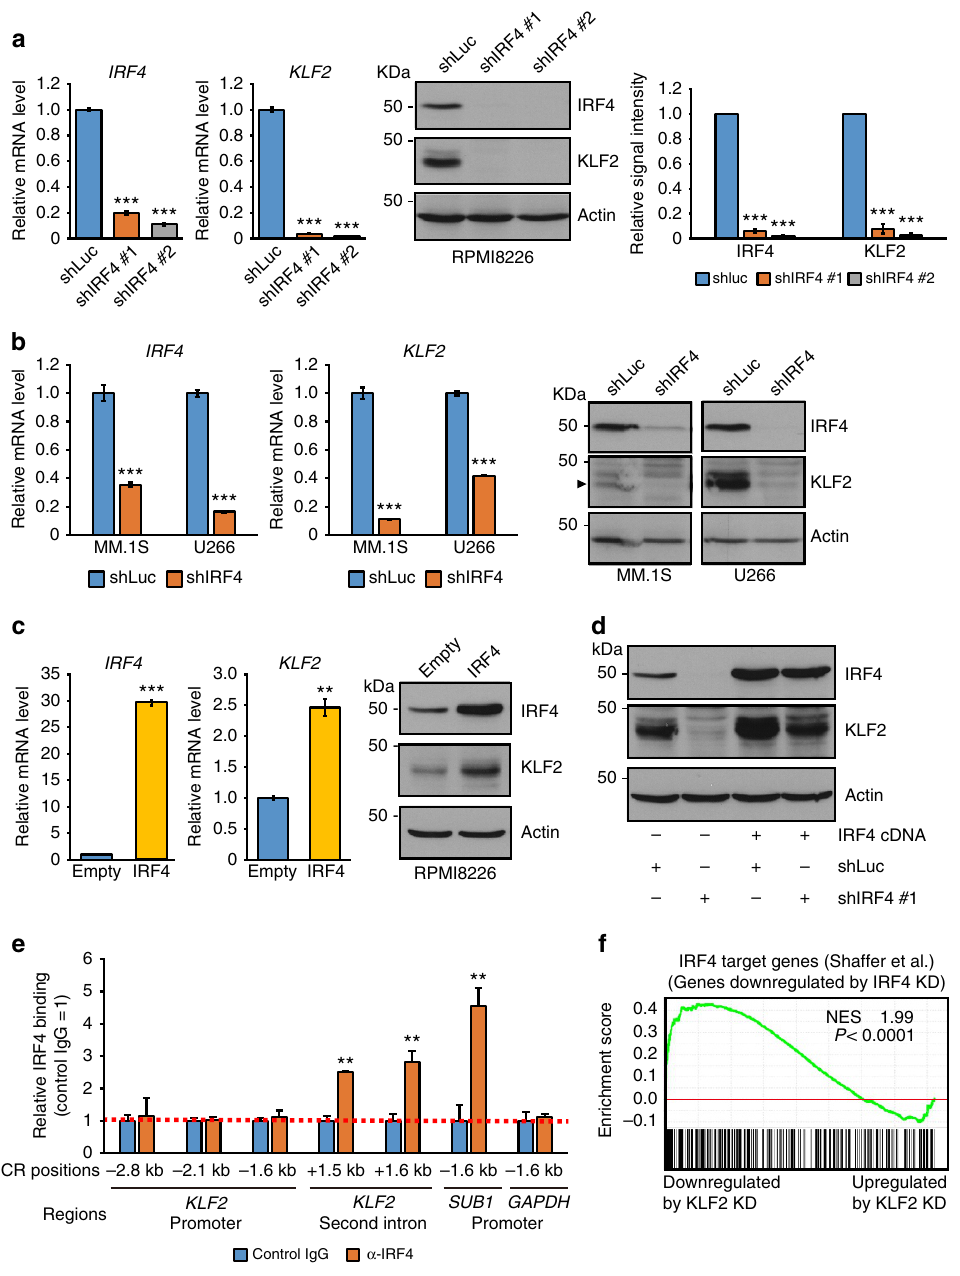
Figure 6 | KLF2 is a direct target of IRF4 transactivation in MM cells. ( a , b ) Quantitative real-time PCR and immunoblot analysis of IRF4 and KLF2 in RPMI8226 ( a ), MM.1S and U266 ( b ) cells transduced with either shRNA targeting IRF4 (shIRF4) or shLuc. ( a , right panel) Shown are the relative signal intensity (shLuc ¼ 1) normalized by Actin. Error bars represent s.e.m. of three independent experiments. ( c ) Quantitative real-time PCR and immunoblot analysis of IRF4 and KLF2 after overexpression of IRF4 in RPMI8226 cells. ( d ) RPMI8226 cells expressing the IRF4 cDNA or empty vector were transduced with shIRF4 #1 that targets the 3 0 untranslated region of IRF4 or shLuc by lentivirus. Whole-cell lysates were subjected to immunoblot analysis with antibodies against IRF4 and KLF2. ( e ) ChIP analysis showing IRF4 occupancy on KLF2 second intron in RPMI8226 cells. ChIP assays were performed for the regions that contain tandem IRF4 motifs on KLF2 promoter and intron (indicated PCR positions are relative to the transcriptional start site). Results were normalized to control IgG. The SUB1 promoter 29 or GAPDH promoter was used as positive or negative control, respectively. ( f ) Significant correlation between the genes downregulated by KLF2 knockdown and IRF4 knockdown in MM cells. The genes significantly downregulated by IRF4 knockdown 29 were used as gene set for GSEA. NES and P values are shown. For a (left panel), b , c , e , error bars represent s.d. of triplicate measurements. For a – e , data are representative of at least two independent experiments. ** P o 0.01, *** P o 0.001 compared with control; Student’s t